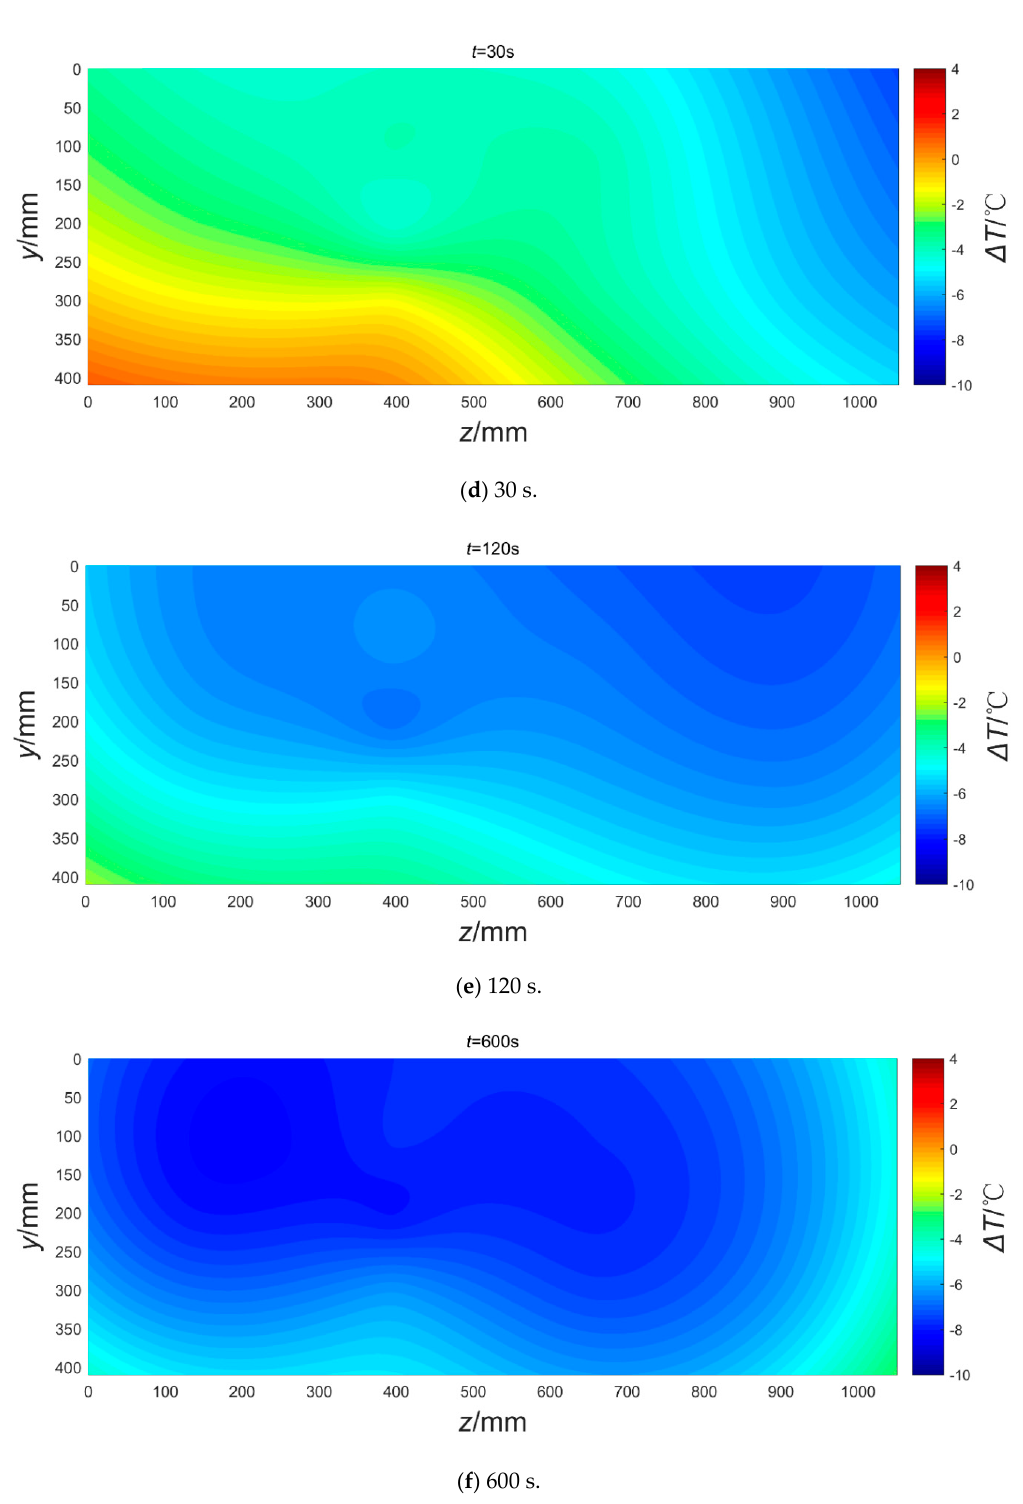
Figure 8. The temperature variation fields on the x = 205 mm plane after the outburst trigger.